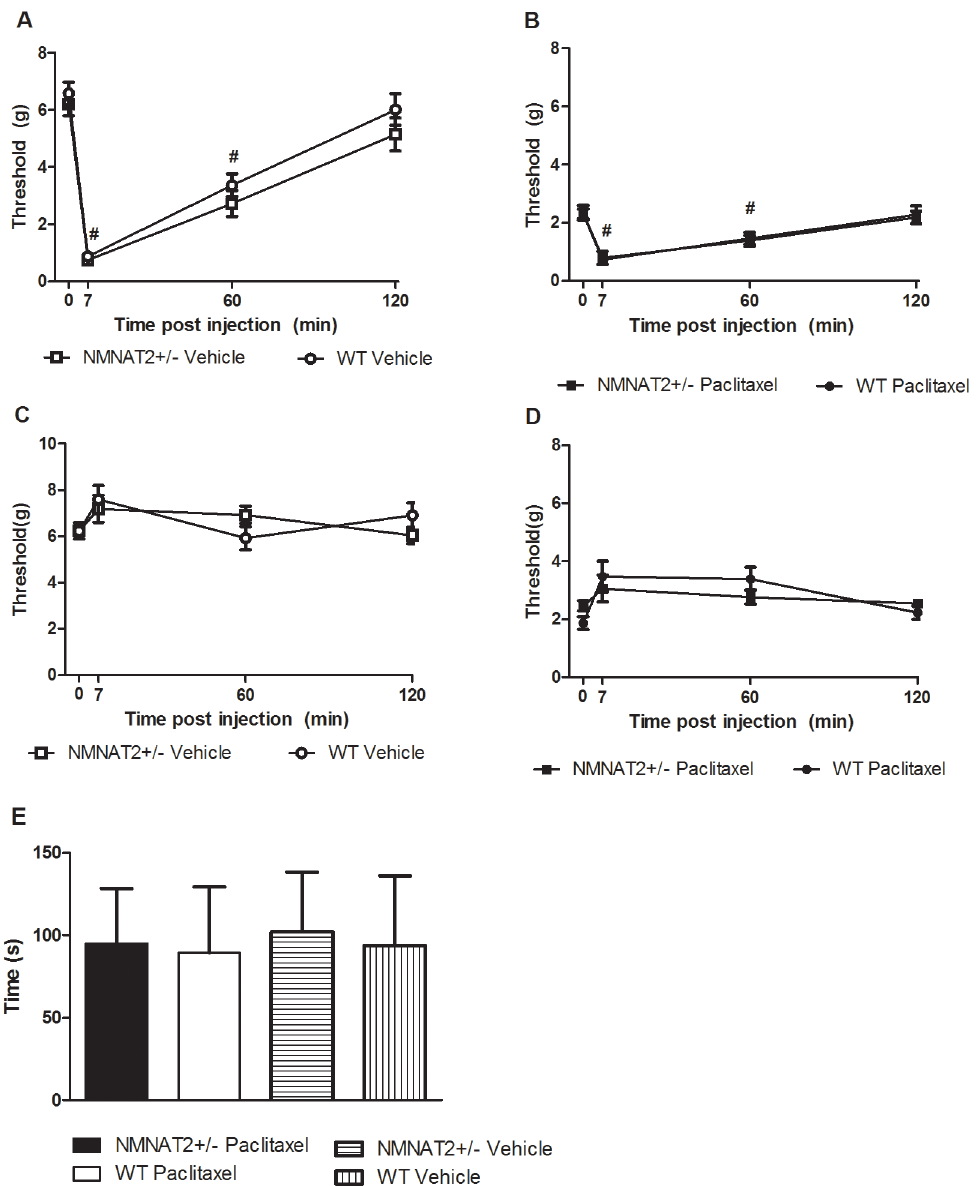
Fig 6. Capsaicin-evoked mechanical hypersensitivity and nocifensive behavior did not differ between NMNAT2+/- and WT mice with identical histories of either paclitaxel or cremophor vehicle treatment. No differences were observed between genotypes in mechanical paw withdrawal thresholds assessed ipsilateral (A, B) or contralateral (C, D) to capsaicin injection in either paclitaxel-treated (B, D) or paclitaxel-untreated (receiving cremophor-vehicle) (A, C) mice. Capsaicin-evoked nocifensive behavior did not differ between groups (E). Data are expressed as mean ± SEM (NMNAT2 +/- vehicle n = 8, NMNAT 2+/- paclitaxel n = 8, WT vehicle n = 5, WT paclitaxel = 5). # p < .05 vs. pre-capsaicin baseline, repeated measures